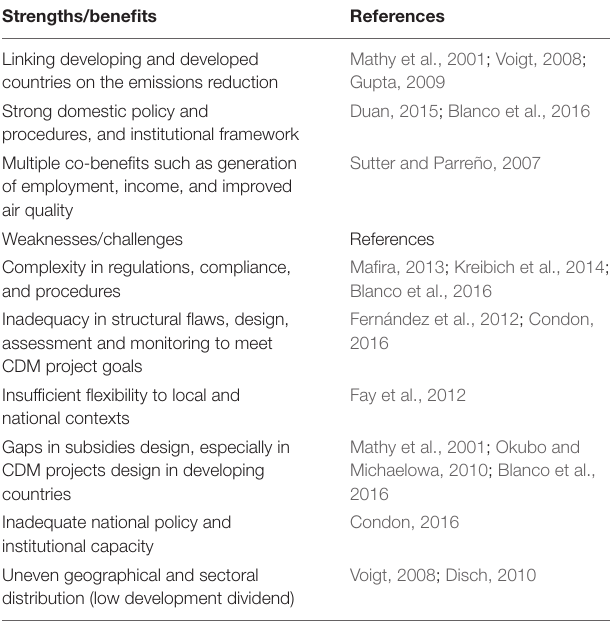
TABLE 4 | Key strengths and weaknesses related to